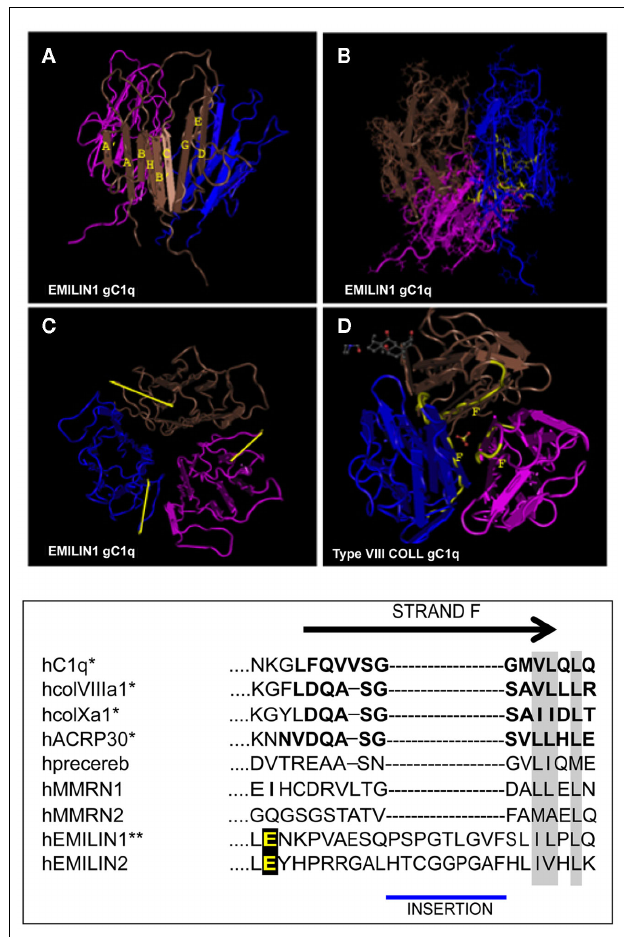
FIGURE 2 |Top: NMR solution structure of the homotrimeric EMILIN1 gC1q domain. The structure was downloaded from database of protein structures maintained at NCBI site (http://www.ncbi.nlm.nih.gov/Structure/ mmdb/mmdbsrv.cgi?uid = 68072). Ribbon representation of the assembly, as side view, is presented in (A) the three protomers in the trimer are shown in different colors ( pink, blue , and brown ). Each monomer has a nine-stranded folding topology, with strands labeled according to the gC1q/tumor necrosis factor superfamily nomenclature. (B) The residues highly conserved in all the members of the gC1q superfamily and essential for a correct domain folding are shown in yellow only in one monomer for clarity. (C) Top view of EMILIN1 gC1q domain.The yellow bar highlights the solvent exposed position of the unstructured segmentTyr927–Gly945 (D) the X-ray structure of typeVIII collagen gC1q, http://www.ncbi.nlm.nih. gov/Structure/mmdb/mmdbsrv.cgi?uid = 25284, showing the buried position of strand F.The same position of strand F is present in the X-ray solution structures of ACRP, type X collagen and Complement gC1q domains. Bottom: Sequence alignment between strand F (residues in bold) of representative members of the C1q superfamily and EMILINs gC1q. Asterisks indicate proteins for which the structure has been solved. Similar residues that are conserved in all proteins are shaded in gray , and the glutamic acid residue interacting whit α 4 β 1 is in